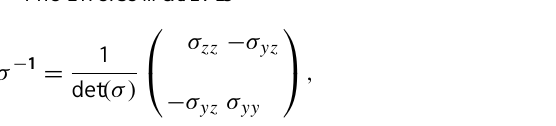
Fig. 2. CoCiP simulation framework. For a list of CoCiP modules, see Table